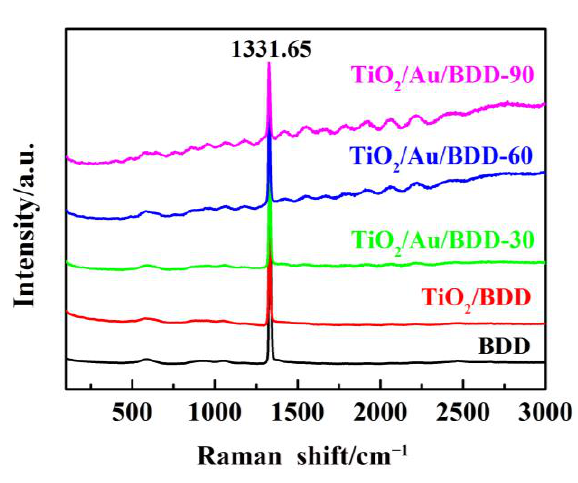
Figure 3. Raman spectra of the BDD, TiO 2 /BDD, TiO 2 /Au/BDD